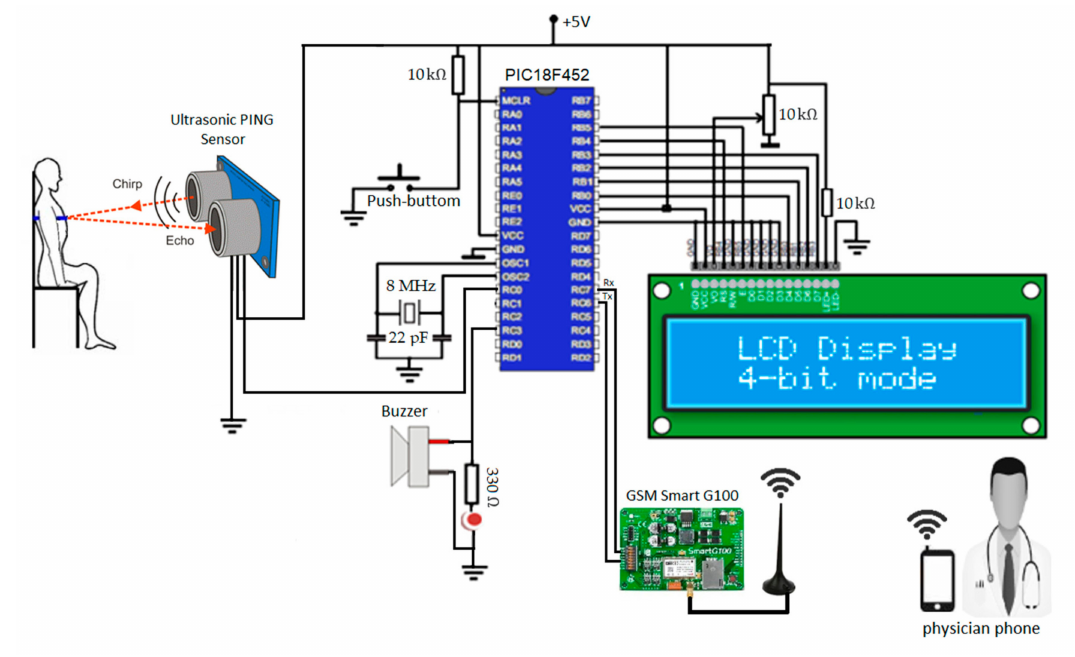
Figure 2. Schematic diagram of the proposed monitoring system.